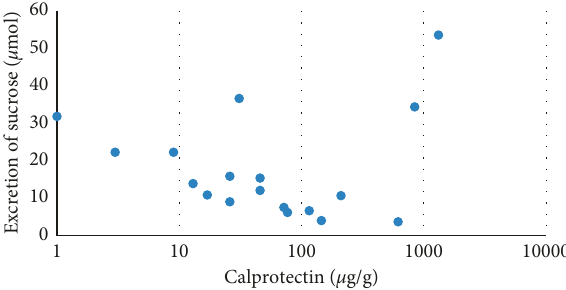
Figure 5: Correlation ( r excretion of sucrose and calprotectin concentrations at baseline in UC patients in remission ( n